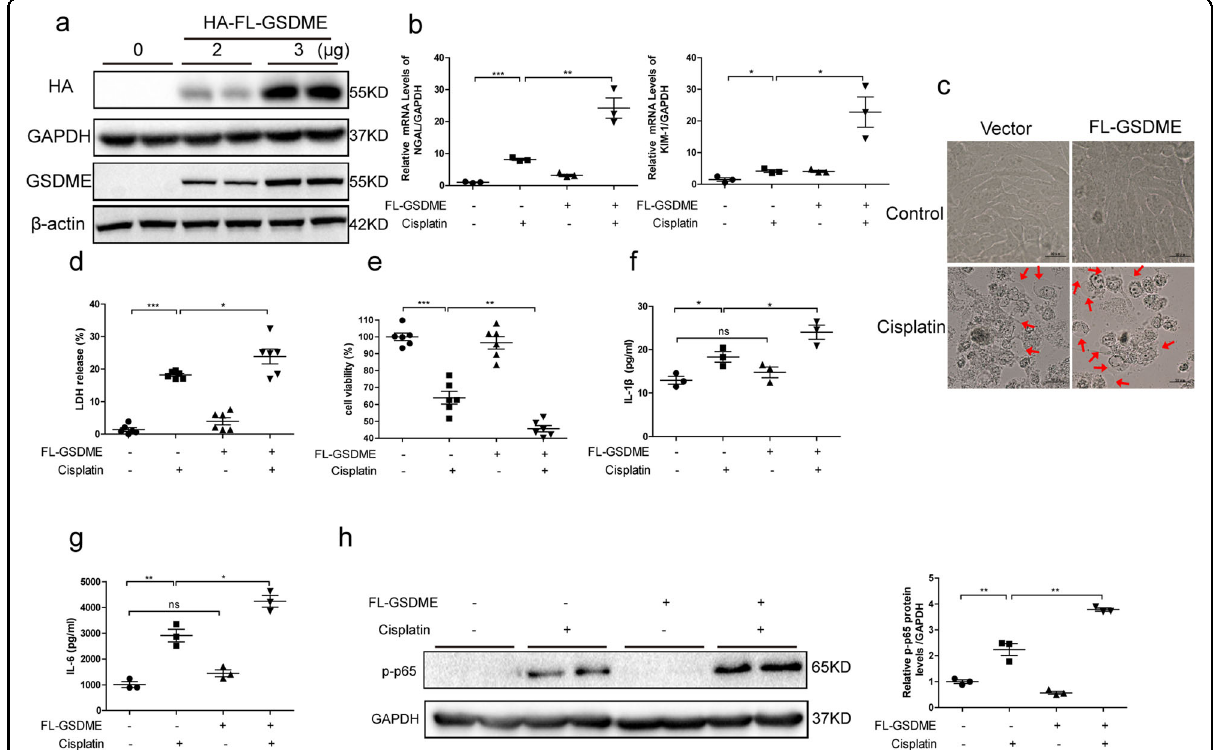
Fig. 5 FL-GSDME aggravated cisplatin-induced cell injury and pyroptosis in human TECs. Human TECs (HK-2) were transfected with FL-GSDME or the corresponding control and subsequently treated with cisplatin (10 μ g/mL) for 24 h. a Protein expression of HA-FL-GSDME with HA and GSDME antibody. b Transcriptional levels of NGAL and KIM-1 ( n = 3). c Representative bright- fi eld microscopic images of cells. Red arrowheads indicate large bubbles from the plasma membrane (scale bar = 50 μ m). d LDH release in cells overexpressing FL-GSDME ( n = 6). e Effect of FL-GSDME on the cell viability ( n = 6). f , g IL-1 β and IL-6 released in culture medium of cells. h Effect of FL-GSDME on p-p65 protein levels ( n = 3). * P < 0.05, ** P < 0.01, and *** P <